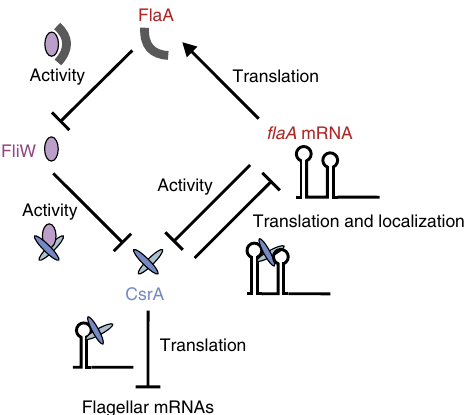
Figure 9 | Model depicting the C. jejuni CsrA-FliW regulatory network. Schematic representation of the regulatory circuit and the putative roles of CsrA, FliW and FlaA proteins along with flaA mRNA in the CsrA-FliW regulon of C. jejuni . The post-transcriptional regulatory protein CsrA represses translation of multiple flagellar mRNAs including flaA mRNA, encoding the major flagellin, by direct binding to the mRNAs. The FliW protein can directly bind and titrate CsrA activity and in-turn affects CsrA- mediated post-transcriptional regulation of flagellar genes. FliW can also bind to the FlaA protein, which releases FliW-mediated sequestration of CsrA. The abundant flaA mRNA is the main target of CsrA translational repression but can also act as a regulatory sponge and titrate CsrA activity together with the main CsrA antagonist FliW. Furthermore, flaA mRNA localizes to the cell poles of elongating cells. Polar localization of flaA mRNA itself is dependent on its translation, which is controlled by the CsrA-FliW regulatory